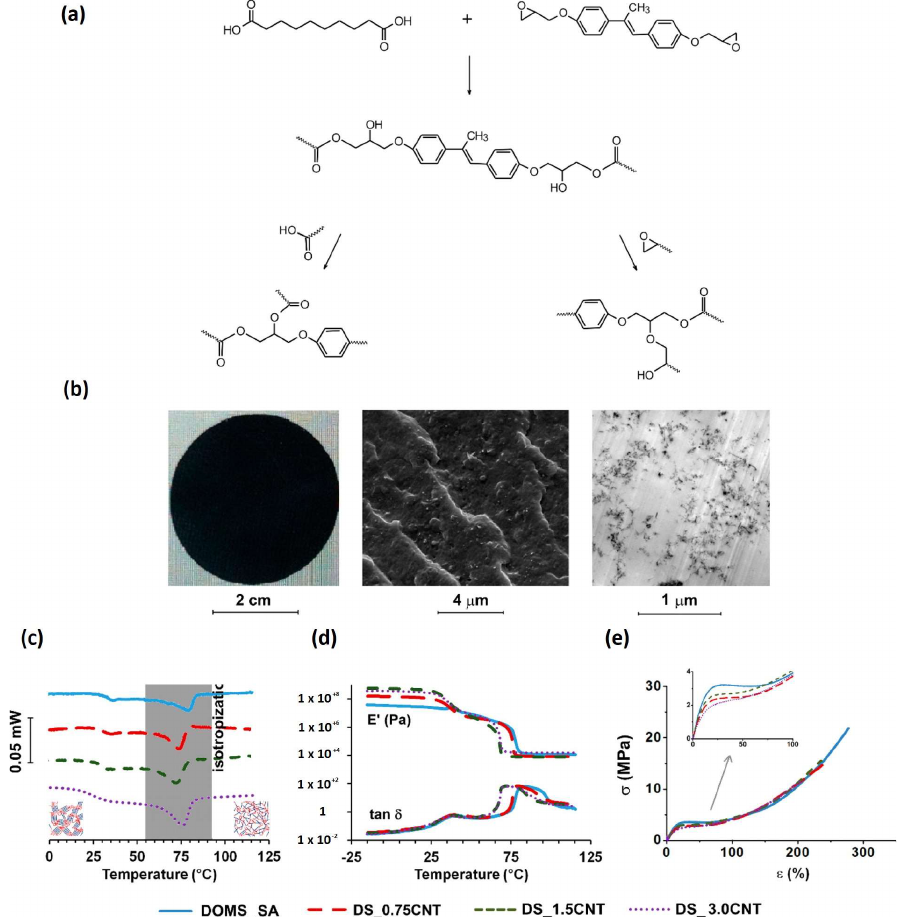
Figure 2. ( a ) Scheme of the synthetic procedure to prepare smectic epoxy-based elastomer film samples (named DOMS_SA). ( b ) Optical image (left), SEM micrograph (center), and bright-field TEM image (right) of a smectic film doped with multi-walled carbon nanotubes (sample DS_1.5CNT). ( c ) Differential scanning calorimetry (DSC) curves of the investigated samples. ( d ) Storage modulus (E’) and tan δ of the investigated samples. ( e ) Stress–strain curves (σ versus ε%) of the investigated samples. Adapted with permission from the authors of [44]. Copyright (2018) American Chemical